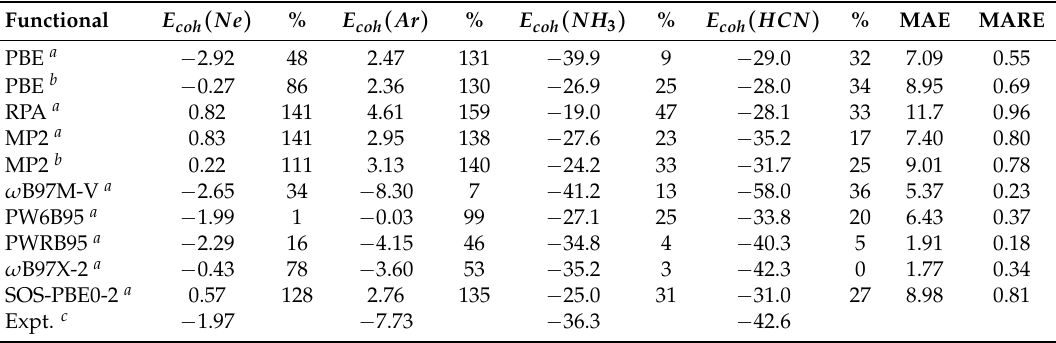
Table 2. Cohesion energies E coh and absolute relative error with respect to experimental results for all considered methods and systems in kJ/mol exploiting basis sets of DZ quality. The statistical indicators are the mean absolute error (MAE) and the mean absolute relative error (MARE). a This work. b Values by Sansonse et al. [63]. c Experimental values [68,71,84], corrected for zero-point energy (ZPE) and thermal effects at 298 K [63,85].